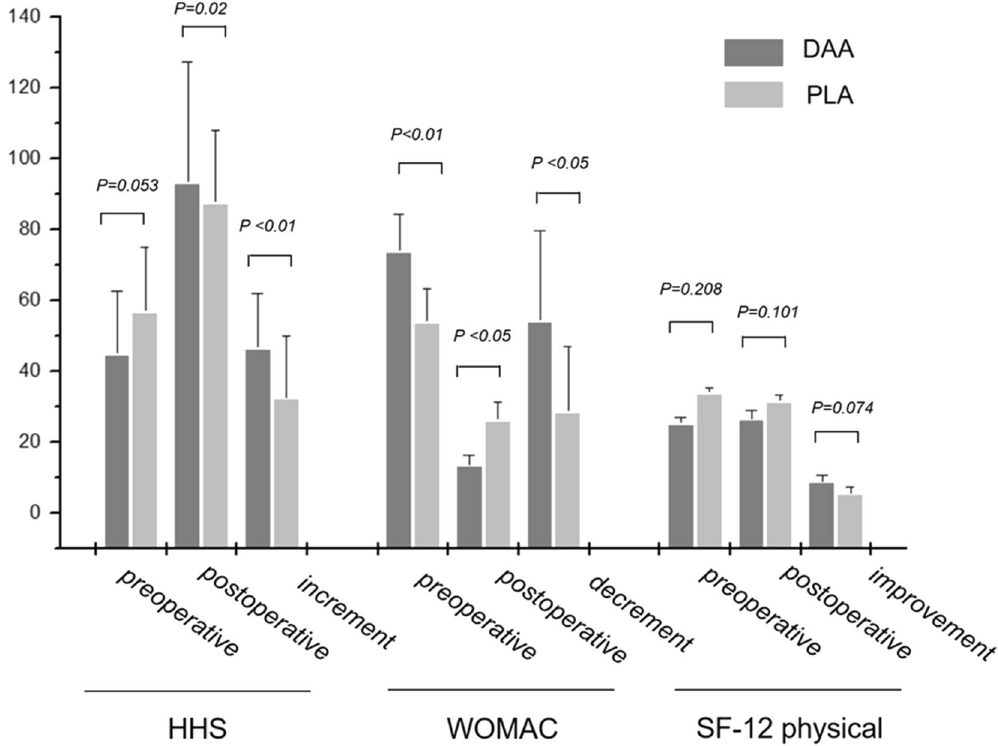
Figure 3. The primary evaluations by patient-reported outcomes of HHS, WOMAC, and SF-12 (physical) measures. Each measure was expressed by preoperative, postoperative values and changes in increment or decrement. P < 0.05 was considered as statistically